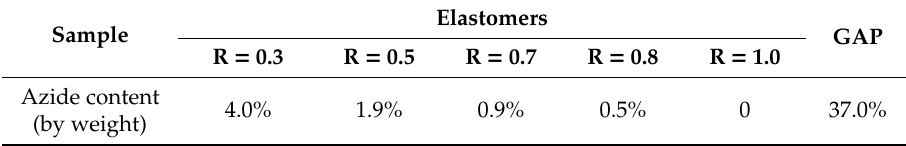
Table 4. The theoretical values of azide content of the polytriazole